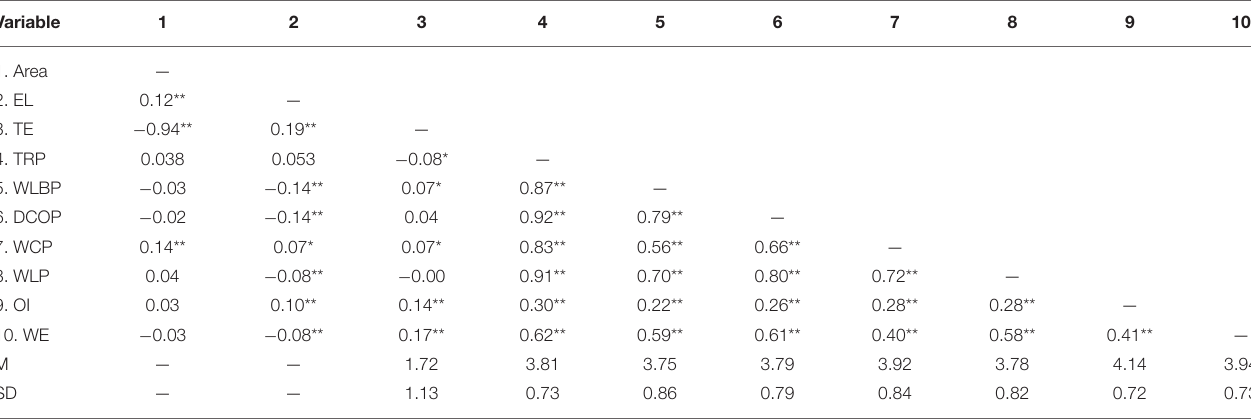
TABLE 2 | Descriptive statistics and correlations among variables.